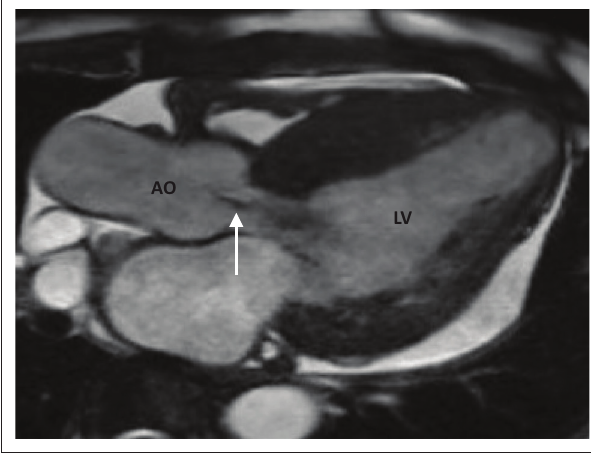
Ao, aorta; LV, left ventricle. FIGURE 16: LVOT cine SSFP image demonstrates a flow jet (white arrow) proximal to the aortic valve, in keeping with aortic regurgitation.